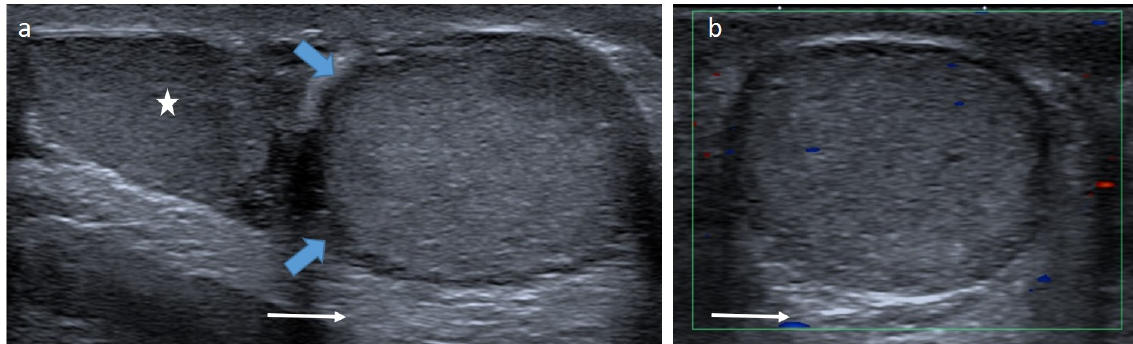
14 of 22 Figure 10 . Testicular adrenal rest tumors in a 6-month boy with congenital adrenal hyperplasia. Transverse gray-scale B-mode ( a ) and color Doppler ( b ) US of the testis. Images show bilateral and symmetric lesions at the hilum of the testis, mostly hypoechoic with a hyperechoic center, lobulated margins (blue arrow) and increased intralesional flow preserving the normal vascular architecture. US, ultrasonography. Courtesy of Pr Laurence Rocher, Antoine Béclère, Clamart, France.